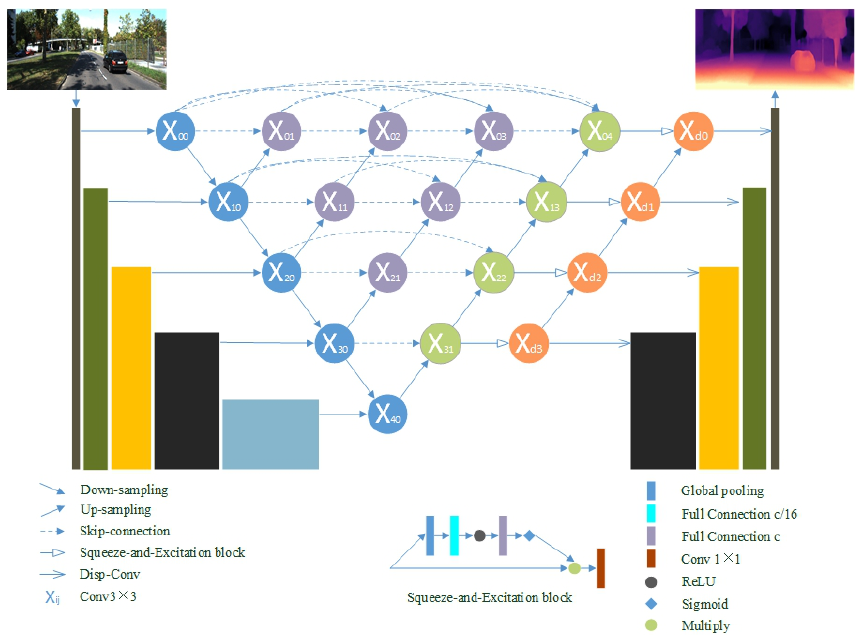
Figure 5. Skip connections